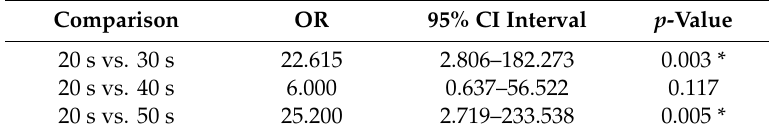
Table 4. Binary logistic regression analysis for risk factor associated with